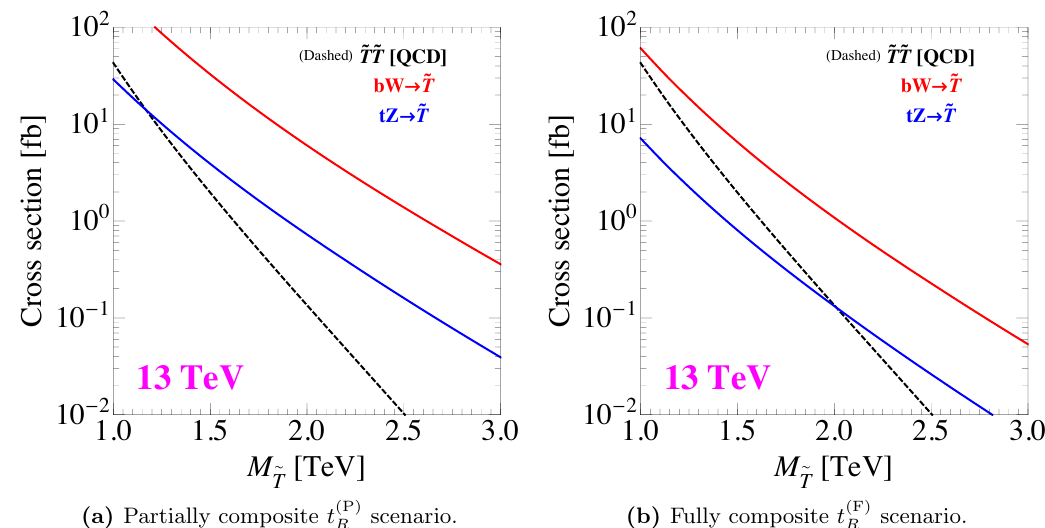
Figure 3. The production cross sections of singlet top partners at the 13 TeV LHC. The parameters used in making these plots are f = 1 TeV, y L = 1 : 5 (1) for LP(F) 1 , while y R , y 2 L are determined by the top quark mass M t = 150 GeV (see eq. (B.18) and eq. (B.21)). Note that bW ! e T process is calculated using bottom